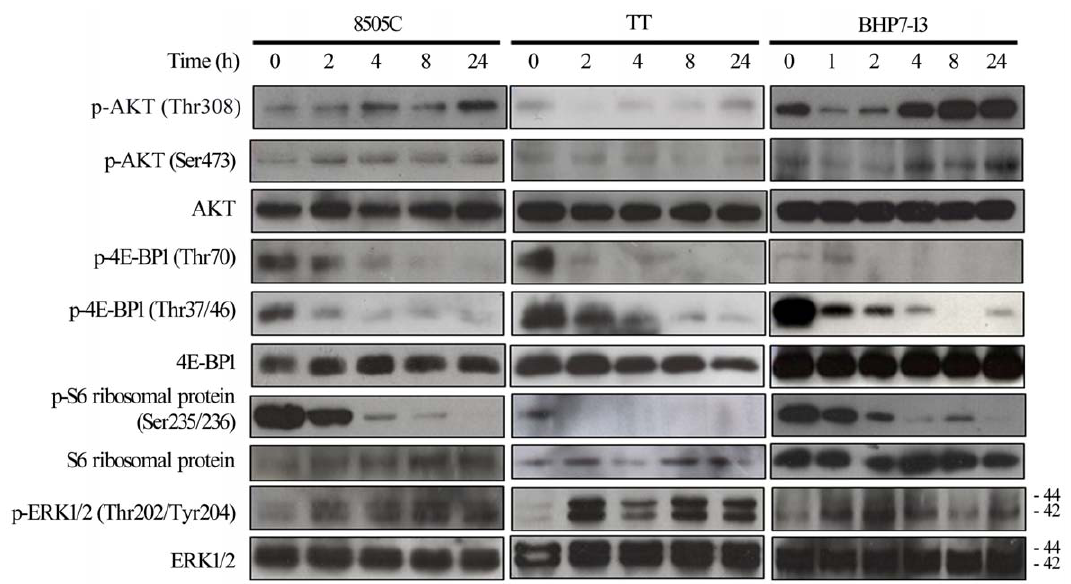
Figure 2. mTORC1downstream signaling is inhibited and p-ERK1/2 is activated by BEZ235 at 100 nmol/L. p-AKT (Thr308) and p-AKT (Ser473) was increased in 8505C for more than 24 hours. p-AKT (Thr308) and p-AKT (Ser473) was decreased transiently in TT and BHP7-13. p-4E-BP1 (Thr70), p-4E-BP1 (Thr37/46) and p-S6 ribosomal protein (Ser235/236) were consistently reduced from 2 hours through over 24 hours in three cell lines. BEZ235 caused a rapid increase of p- ERK1/2 (Thr202/Tyr204) by 2 to 4 hours in three cell